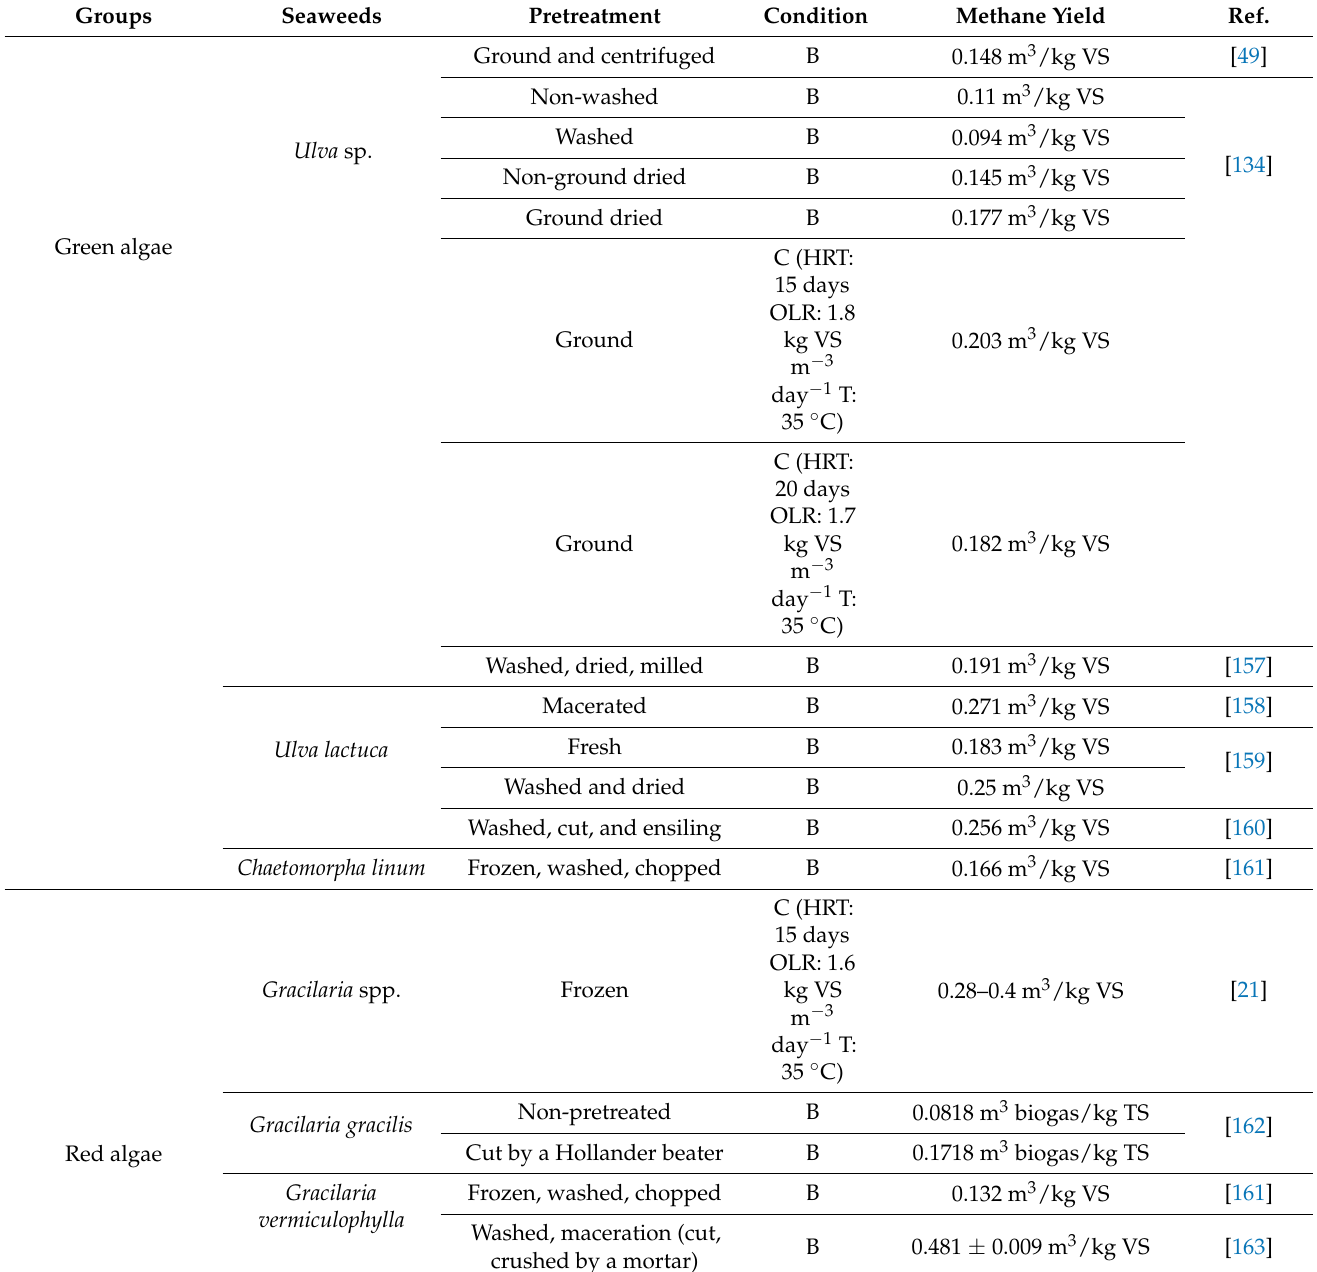
Table 2. Examples of biomethane production and operational conditions with seaweeds as raw